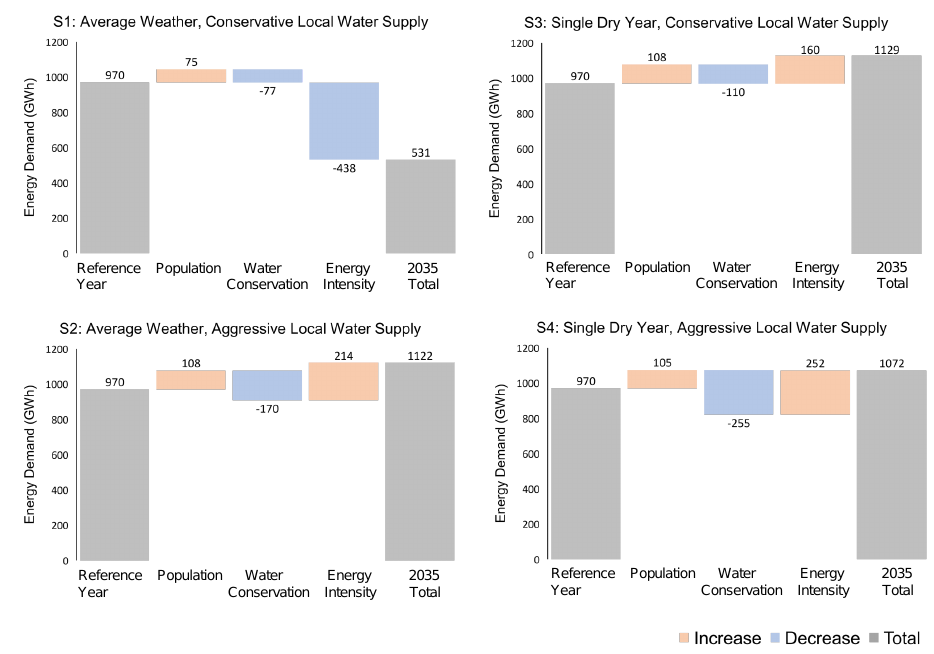
Figure 4. Driving factors for electricity demand changes in 2035 versus the historical average reference year for the four studied water supply scenarios for